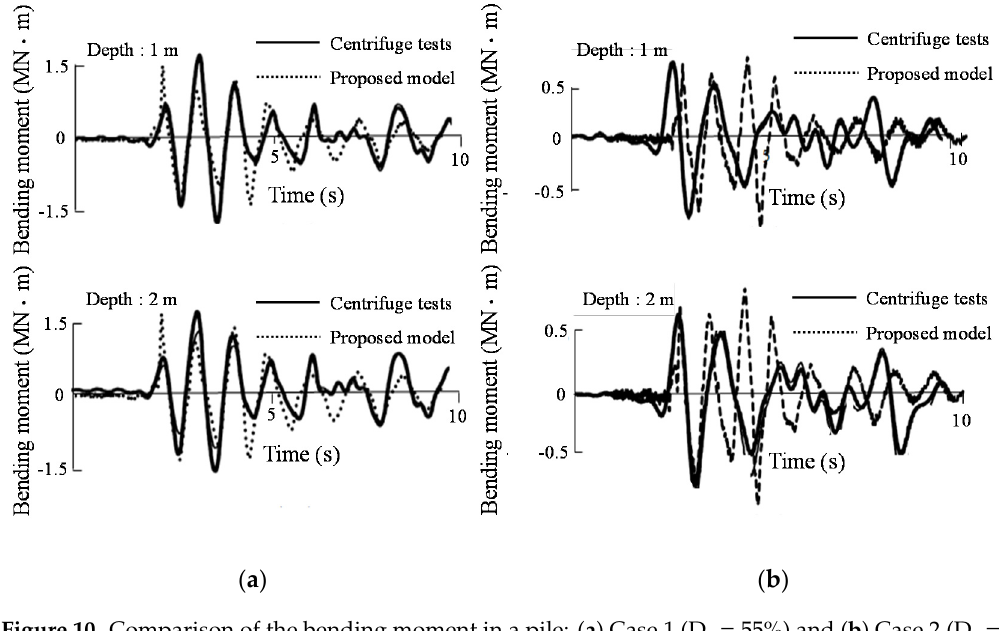
Figure 10. Comparison of the bending moment in a pile: ( a ) Case 1 (D r = 55%) and ( b ) Case 2 (D r = 35%).